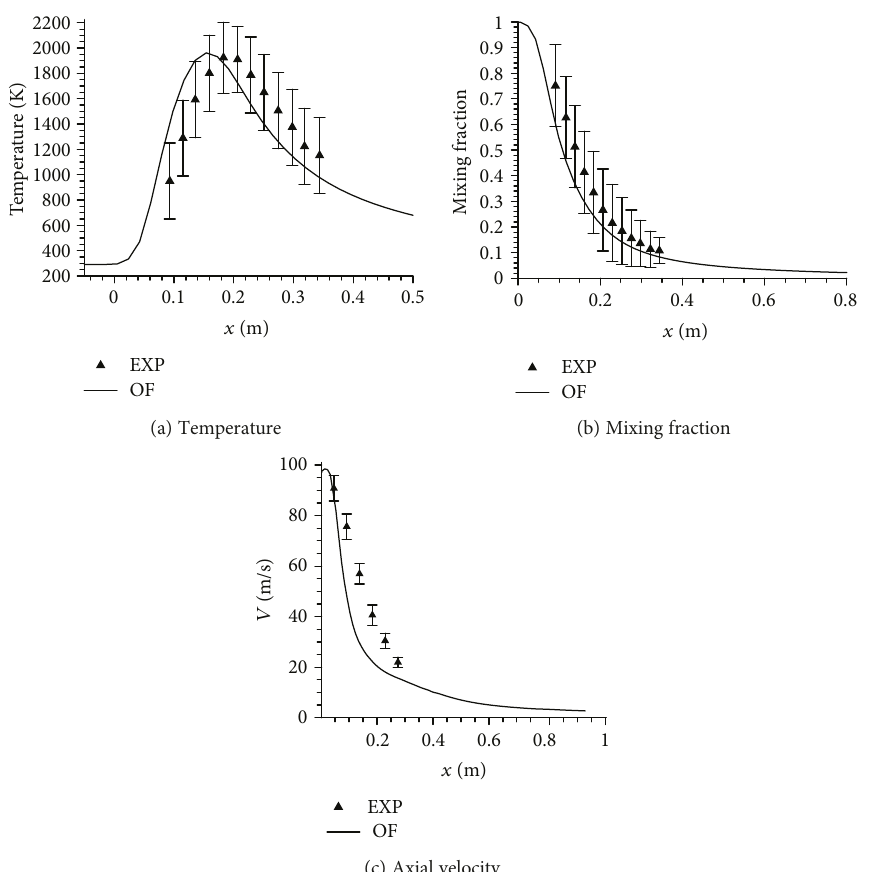
Figure 2: Pro fi le comparison at the centerline of fl ame